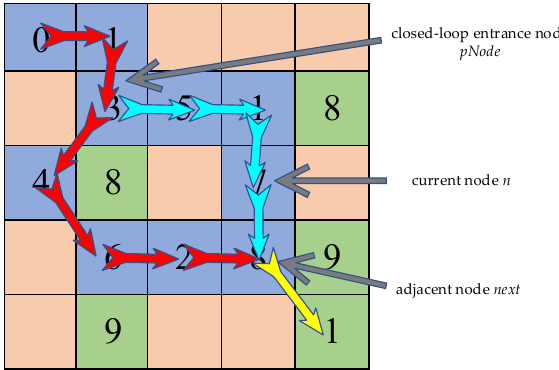
Figure 3. The schematic diagram of closed loop structure of A*